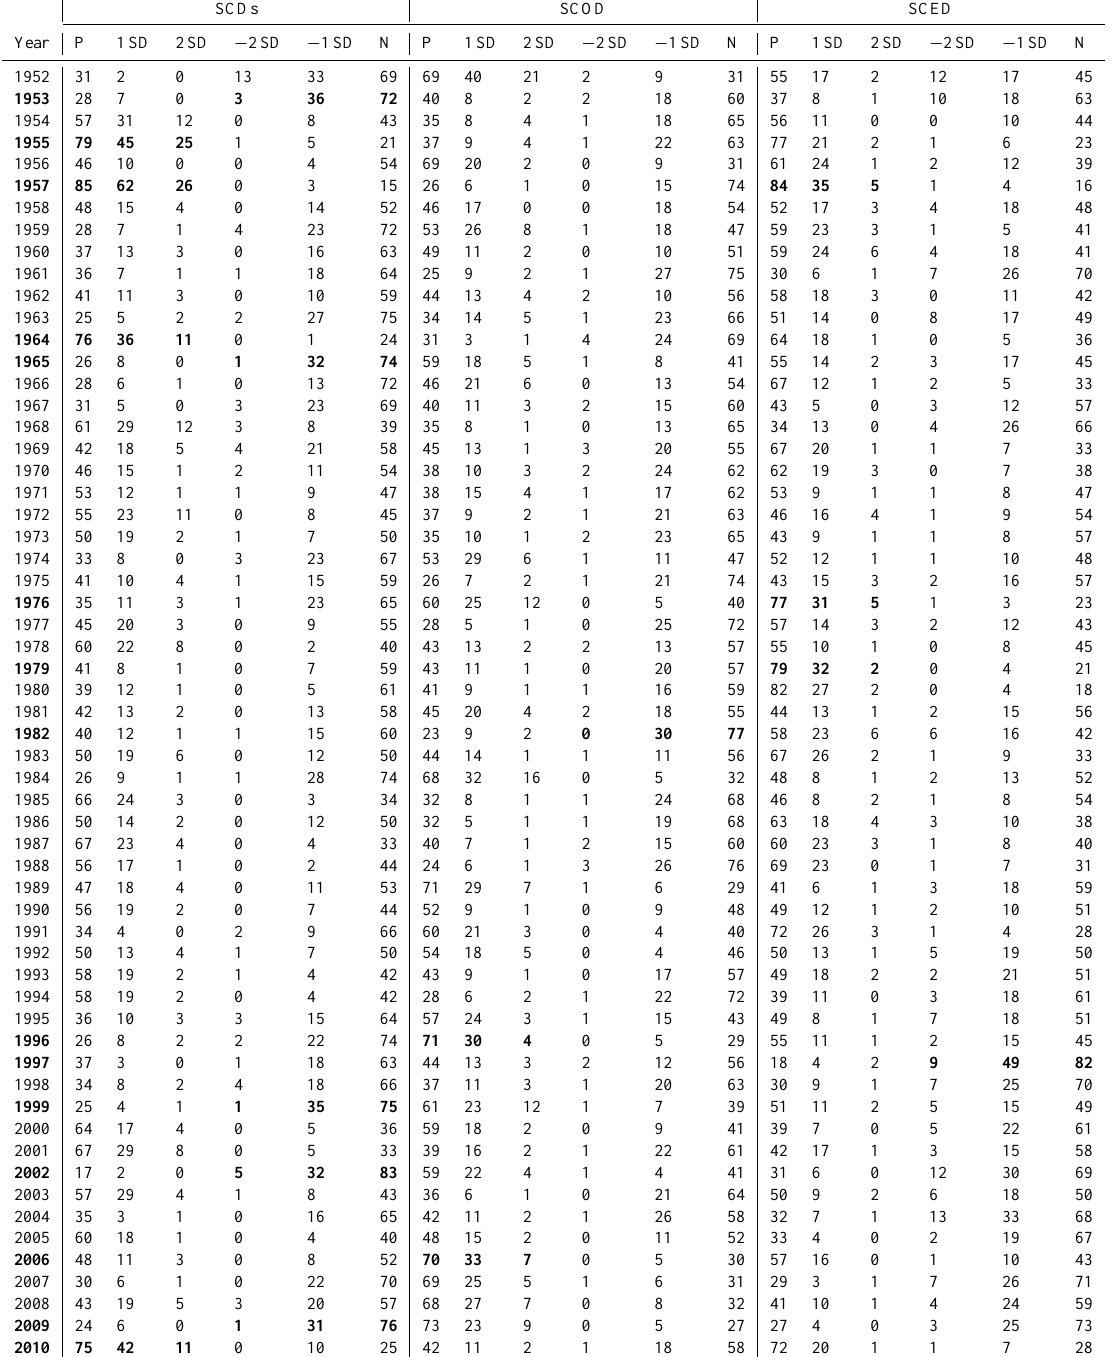
Table 2. Percentage (%) of stations with anomalies (P for positive and N for negative) of snow cover days (SCDs) in a year, snow cover onset date (SCOD), and snow cover end date (SCED). Percentage (%) of stations with anomalies of SCDs, SCOD, and SCED larger (smaller) than the mean ± 1 or 2 standard deviations (SD), with the bold number denoting years with a positive (negative) anomaly of SCDs, and late (early) years for SCOD or SCED in China. All the percentages are calculated based on 672 stations. SCDs SCOD